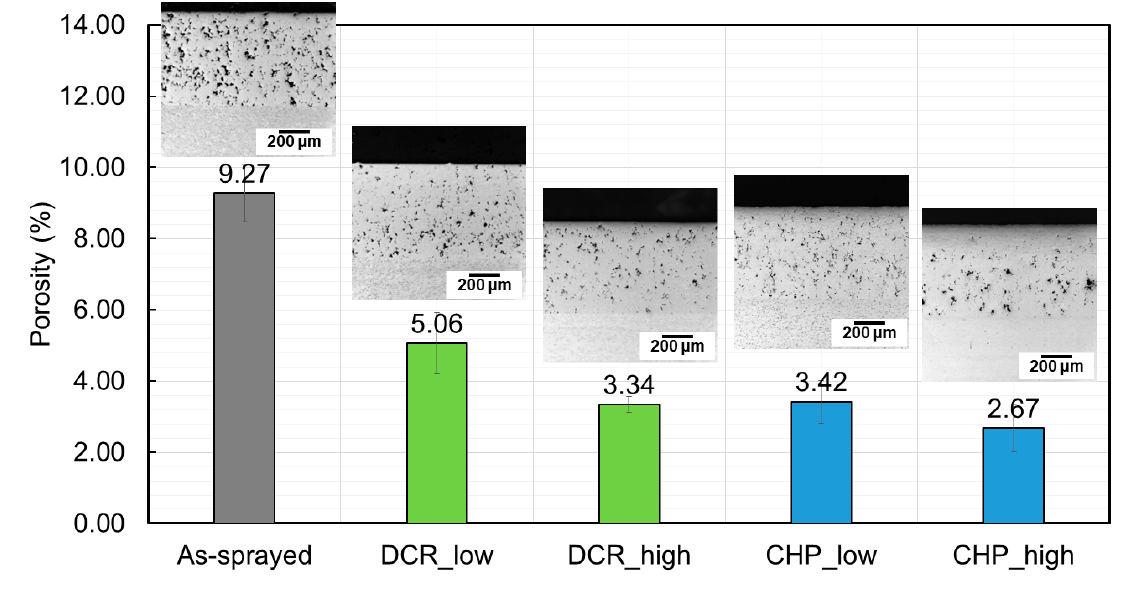
Figure 9. Porosity in coupons post ‐ processed under various conditions.